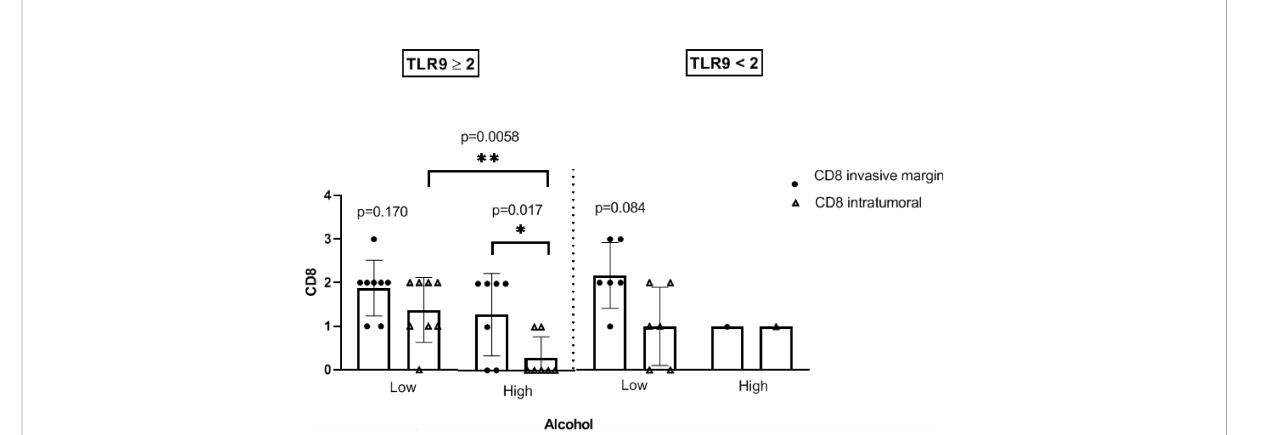
FIGURE 6 TLR9 high tumors that belonged to heavy alcohol consumers presented signi fi cantly fewer CD8+ T cells in the center of the tumor compared to those TLR9 high tumors from low alcohol consumers. Location and scores of CD8+ cells in TLR9 high and low samples from patients who were cataloged as high (heavy) or low alcohol consumers. Student T test was performed. *p < 0.05; **p < 0.001 were considered statistically signi fi